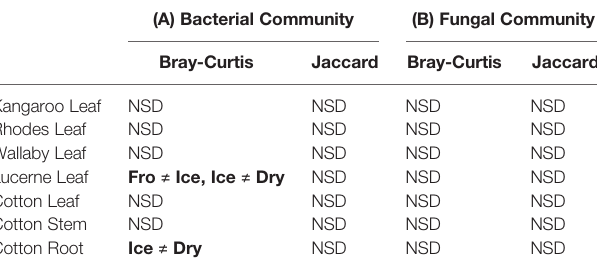
TABLE 1 | Pairwise PERMANOVA analyses of bacterial (A) and fungal (B) communities based on Bray – Curtis and Jaccard measures of square-root transformed relative abundances of plant bacterial communities under different treatments (snap frozen, ice incubation and air dry).. (A) Bacterial Community (B) Fungal Community